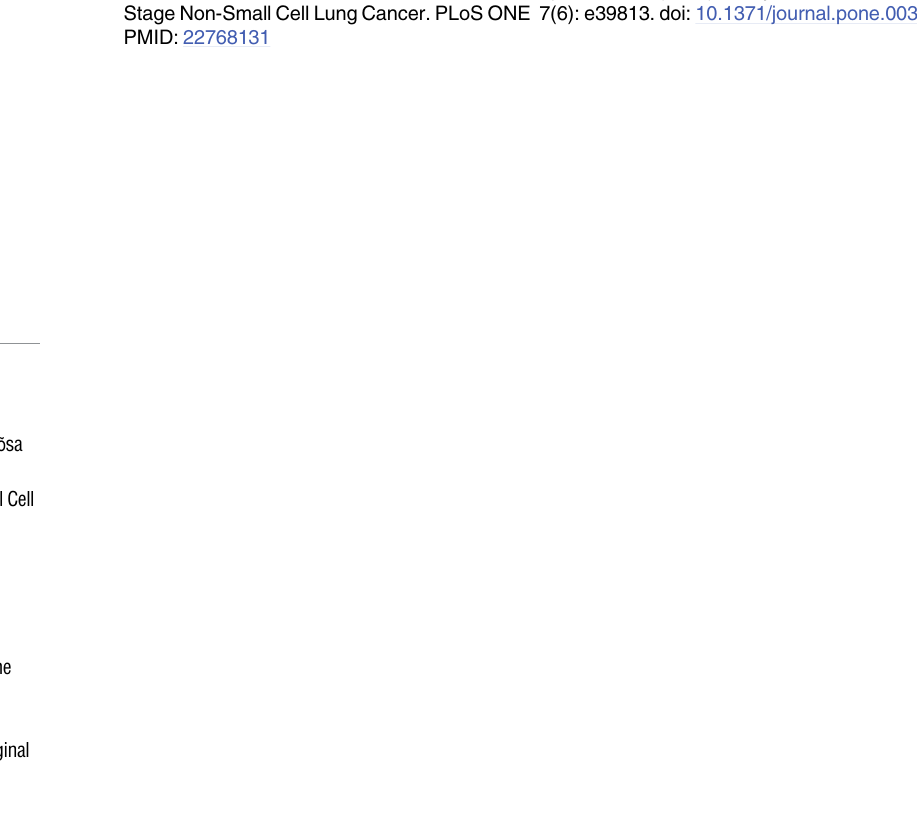
S3 Fig. Scatterplots showing the correlation between beta values determined by Illumina methylation arrays and Sanger bisulfite sequencing. Shown are the best-fitting line, Pear- son’s correlation coefficient and p-value of correlation tests. The mean correlation between two methods was 83% (range 48.9%;